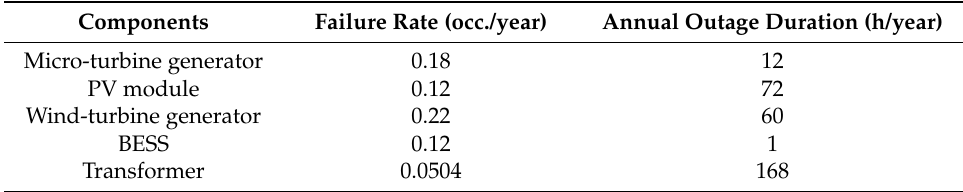
Table 1. Failure rate (occ./year) and annual outage duration (h/year). Table 2. Real power outputs from different distributed generations.